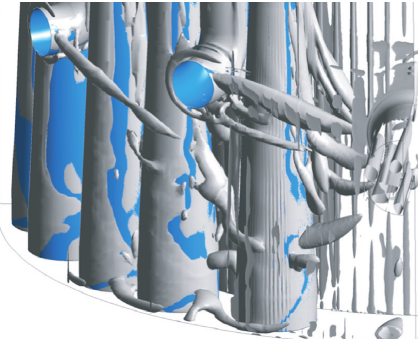
Figure 17: Vortices at the region of